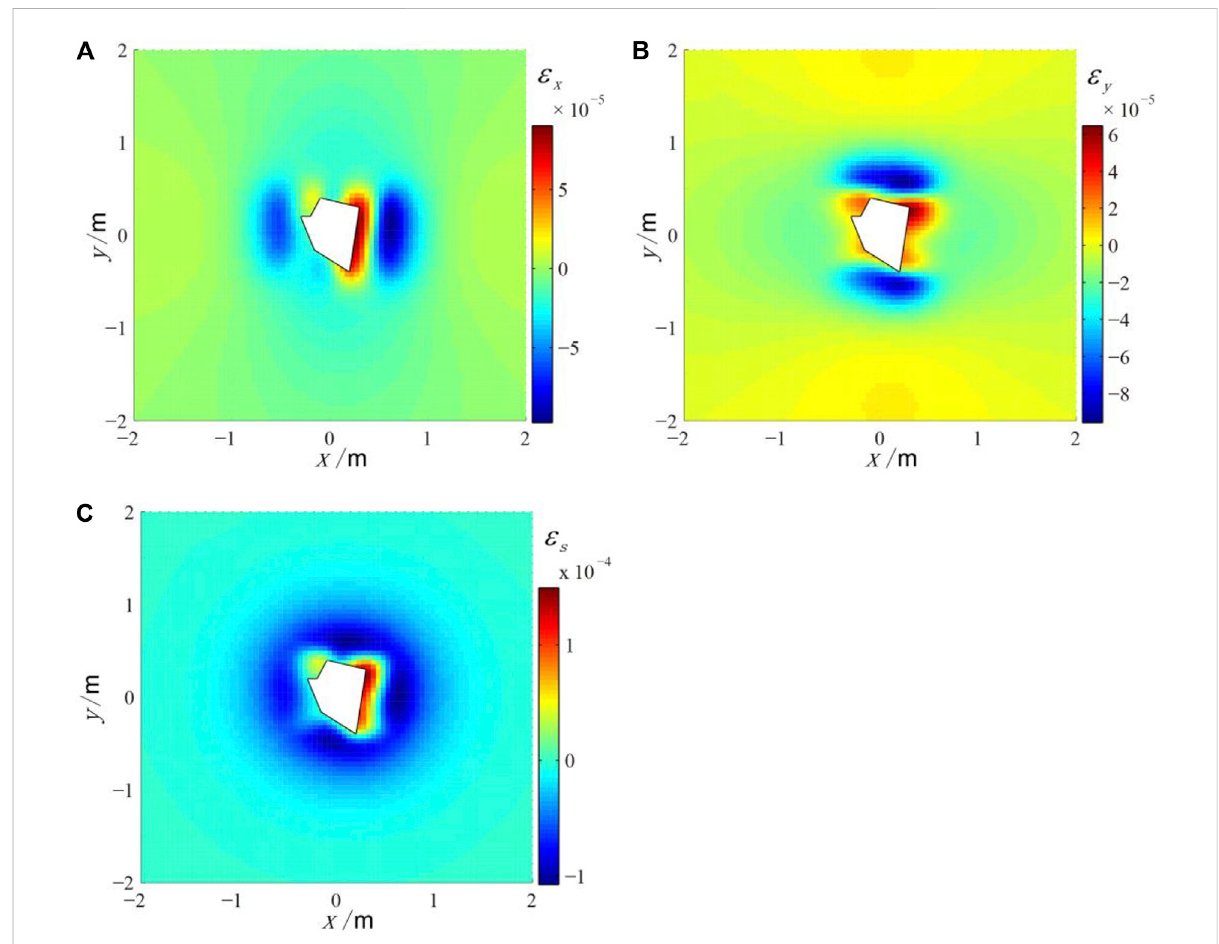
FIGURE 9 Thestrain fi elddisplacementaroundthe3Dirregularloadmodelinthedepthof0.2 m (A) Thelinearstrain ε x ; (B) Thelinearstrain ε y ; (C) Thearea strain ε s ; the white polygon represents the shape of irregular load.